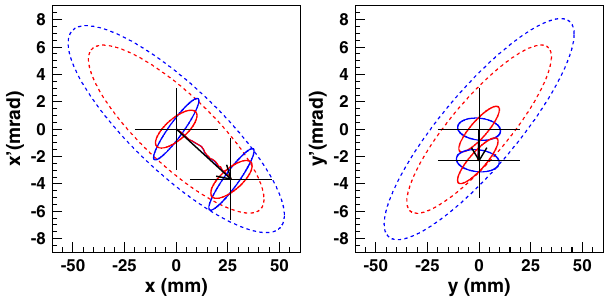
FIG. 23. Transverse injection painting areas evaluated through measurements before (blue) and after (red) the correction of the injection beam Twiss parameter; the solid ellipse represents the injection beam, while the dashed ellipse shows the painting area formed by filling the injection beam ellipse along the black